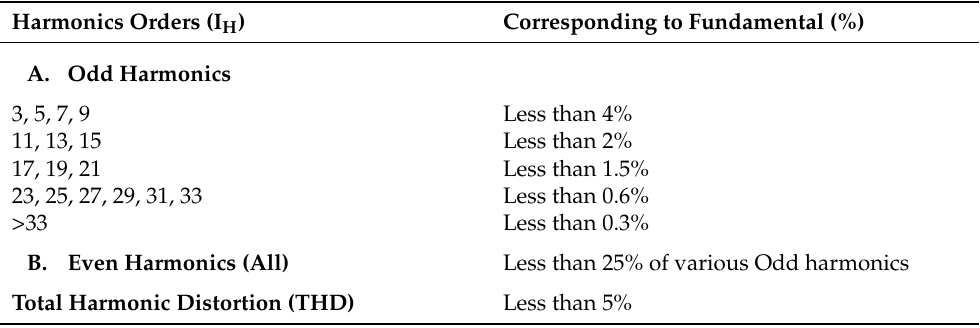
Table 1. Current harmonics limits by IEEE 1547 and IEC 61727 standards [54].